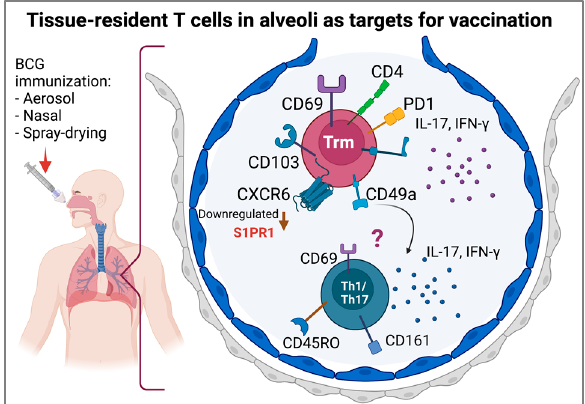
Figure 4. In healthy human lungs, Trms express markers for retention such as CD69, CD103, CD49a, CXCR6, and PD-1 and produce the cytokines IL-17 and IFN- γ . Additionally, a T cell subset with a memory Th1/Th17 phenotype, possibly derived from Trms, has been detected. Both T cell subtypes have been proposed as vaccine targets (created with BioRender.com).